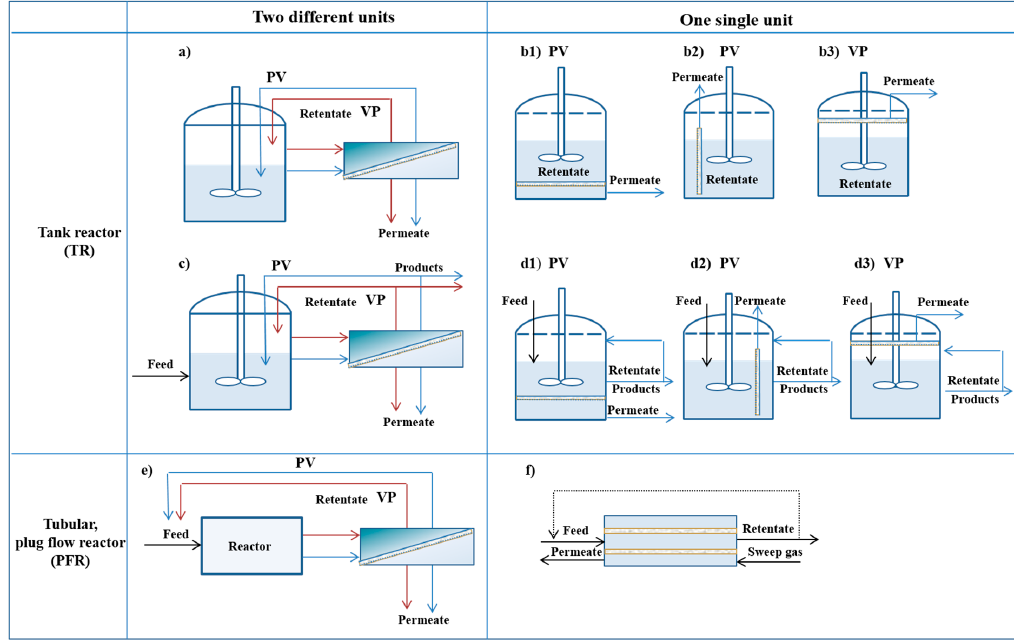
Figure 2. Examples of reactor-membrane separator configurations. TR with external separation unit, TR+PV or TR+VP ( a ); TR with internal flat membrane in PV mode, TRPV ( b1 ), or VP mode TRVP ( b3 ) and tubular membrane, TRPV ( b2 ); ( c ) recycle continuous stirred tank reactor (CSTR) with external separation unit, CST+PV or CST+VP ( c ), or internal unit, CSTPV or CSTVP ( d1 – d3 ); PFR with external separation unit, PFR+VP or PFR+PV ( e ) or internal unit, PRFVP ( f ).